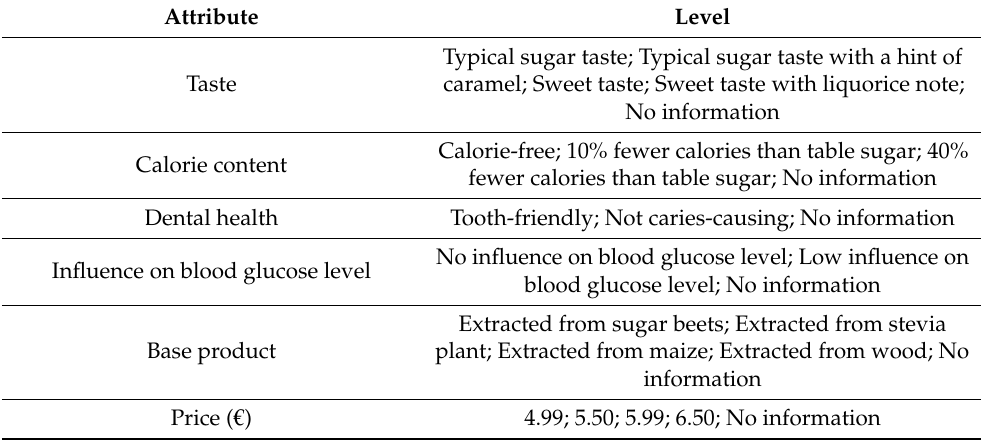
Table 1. Attributes and levels used in the choice experiment.